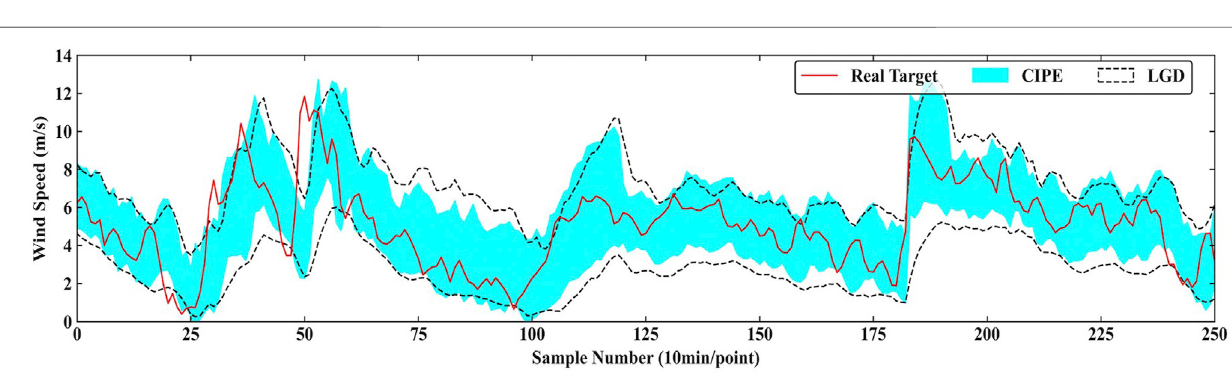
TABLE 5 | Multi-step ahead prediction results of CIP and CIPE under different PINC . PINC (%) PICP (%) ACD (%) PINAW (%) CWC CIP CIPE